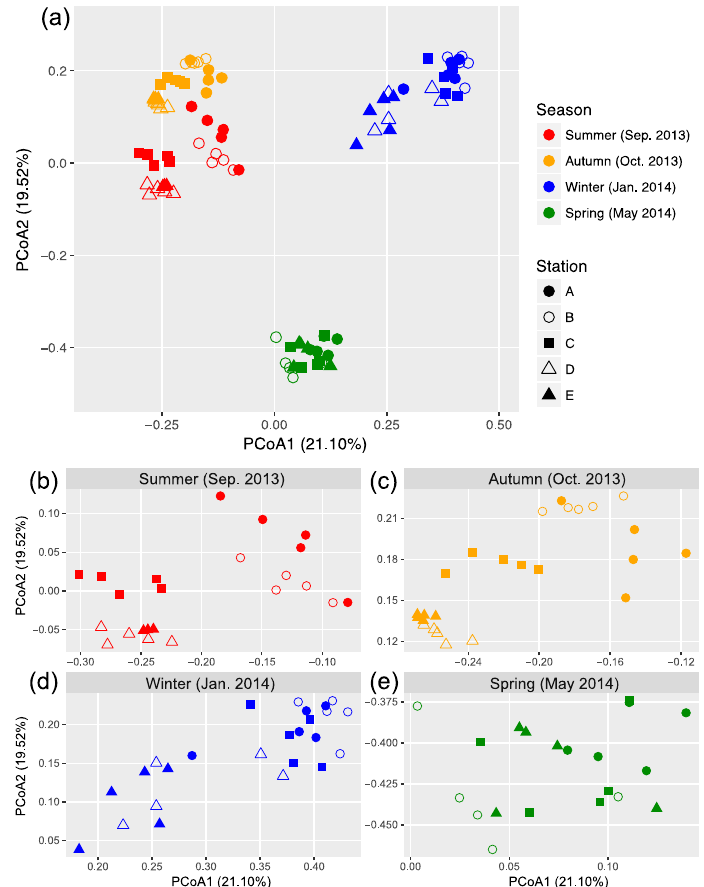
Figure 3. Principal coordinate analysis (PCoA) based on Bray–Curtis dissimilarity illustrating the variation in bacterial community composition across sites ( a ). Data from each season were expanded into separated panels to better illustrate the clustering patterns ( b – e ).